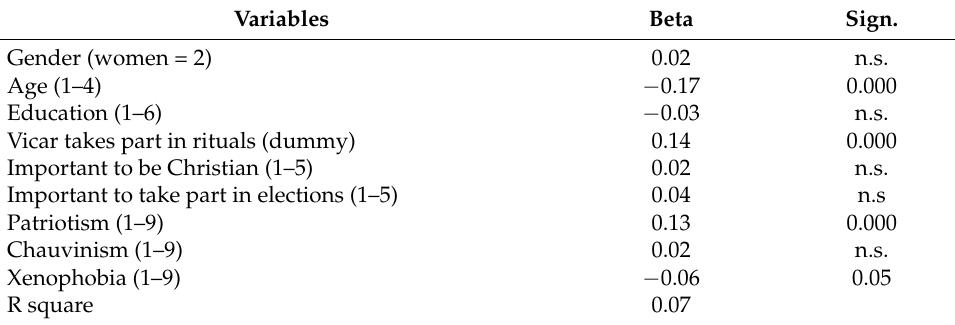
Table 4. Regression analysis where participation in public National Day rituals is the dependent variable (Beta and r square). N = 1468.